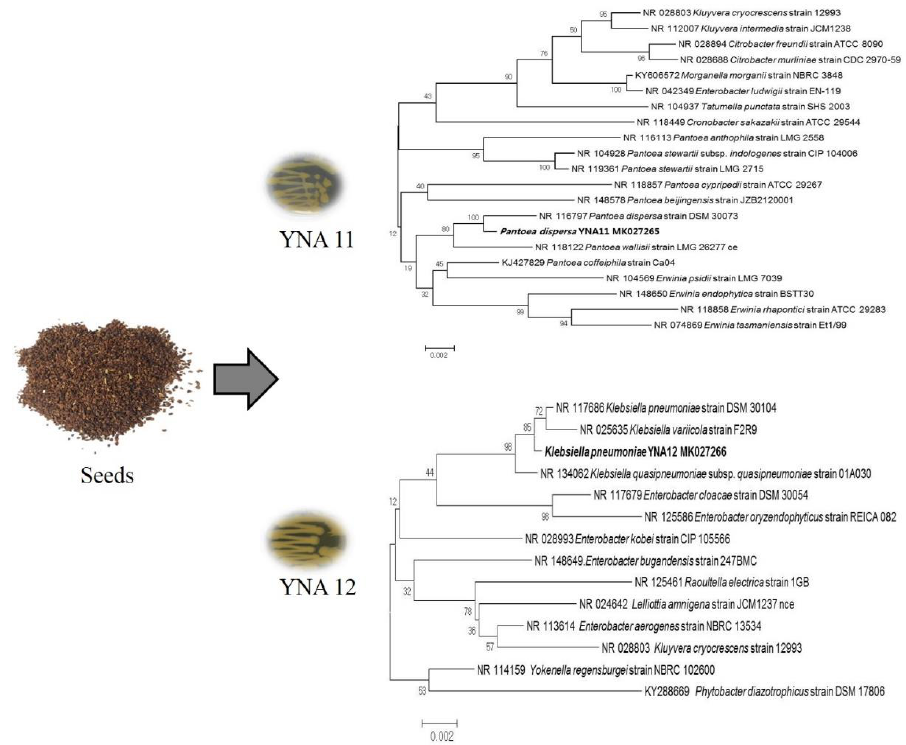
Figure 1. Neighbor-joining (NJ) phylogenetic tree constructed using the 16S rRNA sequences from endophytic YNA11 and YNA12 and related taxa.